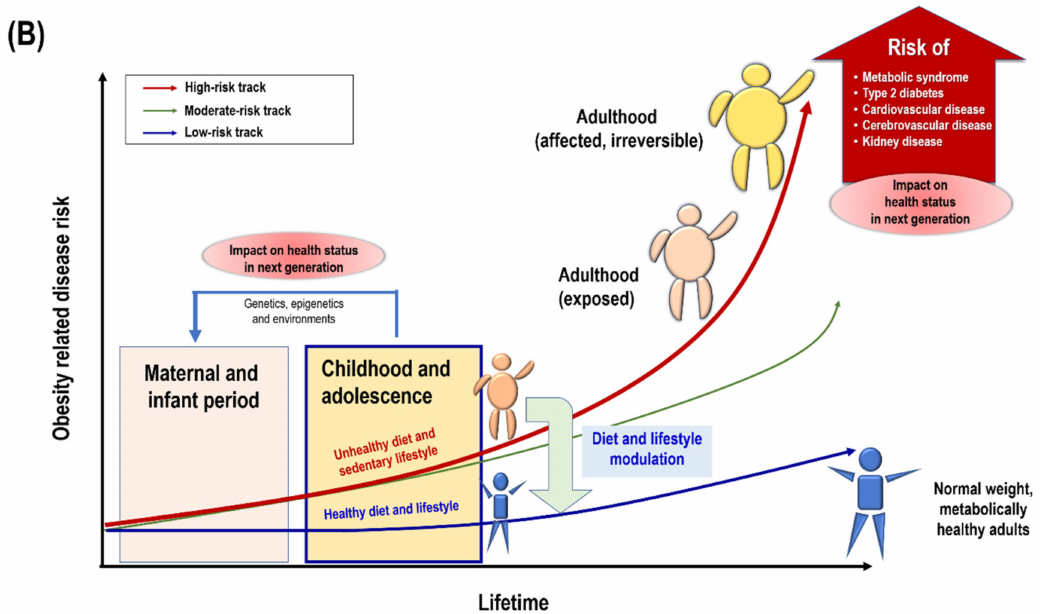
Figure 1. E ff ect of an energy-restricted, balanced diet with macronutrient modulation on body composition and metabolic status in children and adolescents, as well as throughout the lifetime. ( A ) E ff ect of dietary macronutrient modulation on children and adolescent body composition and metabolic status. *Energy restricted, balanced diets are e ff ective in the treatment of obese adolescents and children, but the modulation e ff ects of macronutrient composition on weight loss were inconsistent among the studies ( B ) Obesity-related disease risk throughout the lifetime